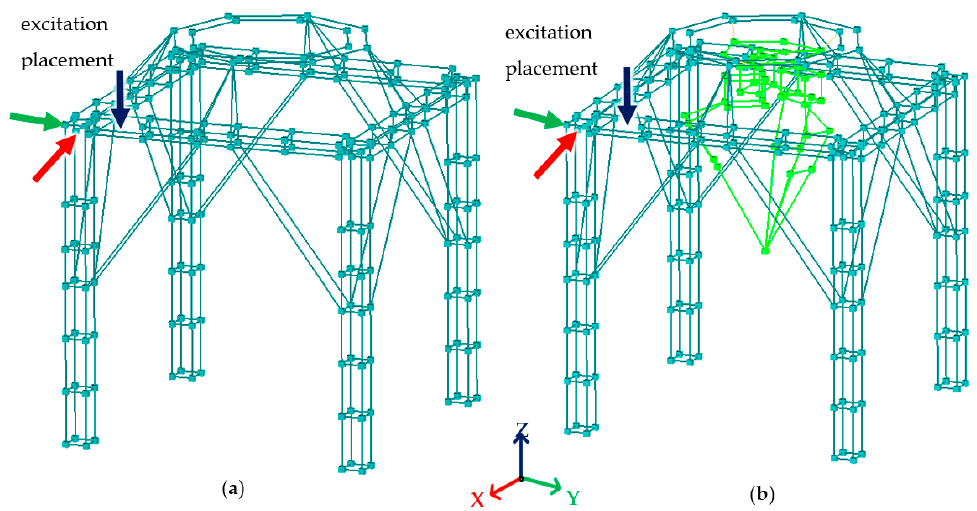
Figure 3. Measurement points arrangement ( a ) for the frame and ( b ) for the frame with the robot.